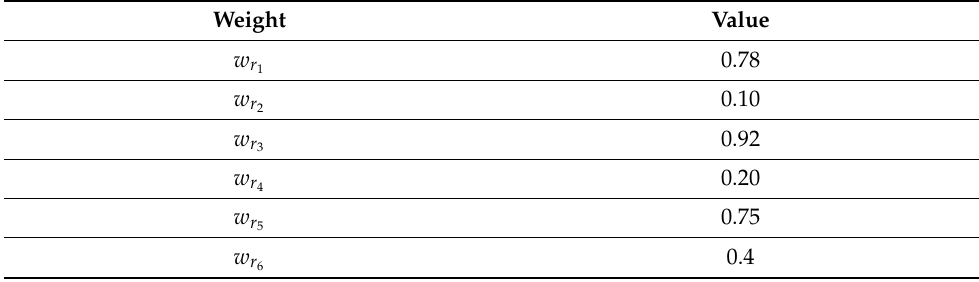
Table 4. Weight of each robot task.